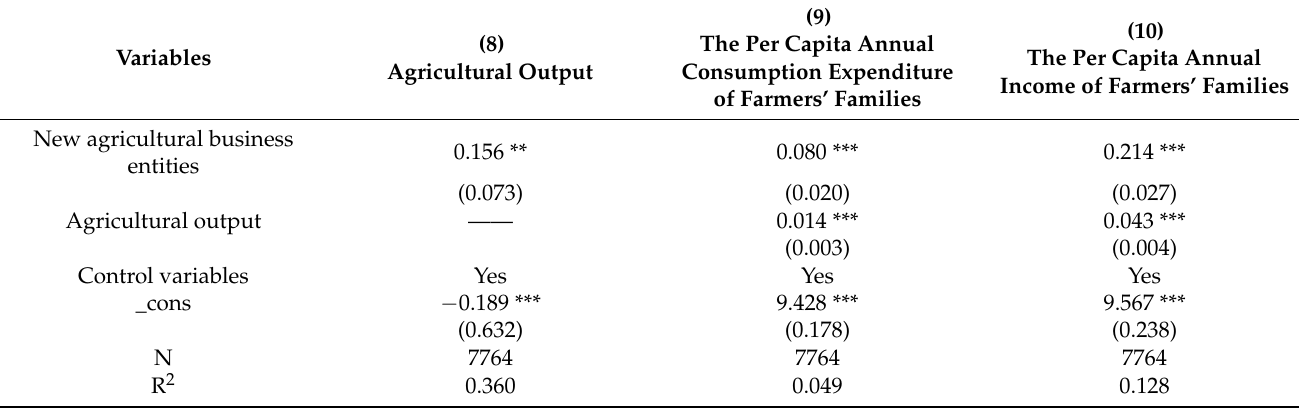
Table 5. The intermediary role of agricultural output in the influence of new agricultural business entities on the economic welfare of farmers’